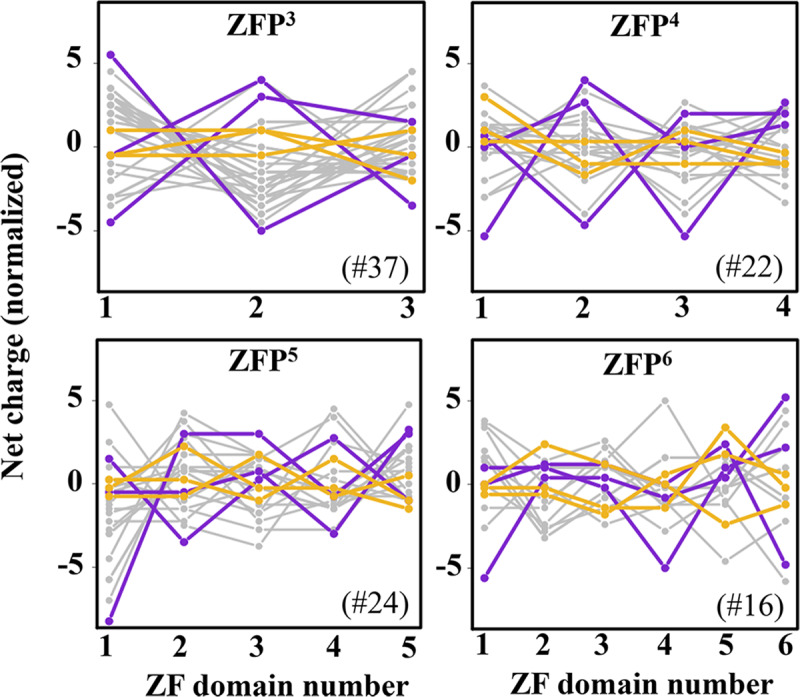
Net charge of individual zinc-finger domains in tandem zinc-finger proteins.The panels show the variation in normalized net charges for zinc finger proteins (ZFPs) comprising 3 (ZFP3) to 6 (ZFP6) zinc finger (ZF) domains. The number of domains is indicated by the superscript on ZFP in the title and the number of proteins shown in each group is indicated in the panel by a # mark. In each panel, three examples of proteins having asymmetric (purple) and symmetric (orange) electrostatics are shown. The normalized net charge of a ZF domain was obtained by subtracting the mean net charge of all the other ZF domains in that protein from the net charge of the ZF of interest.